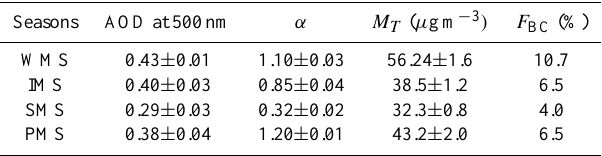
Table 1. Seasonal mean values of (Aerosol Optical Depth) AOD at 500nm, Angstrom wavelength exponent α , mass concentration of composite aerosols M T , and mass fraction of BC to the composite aerosols ( F BC ) .